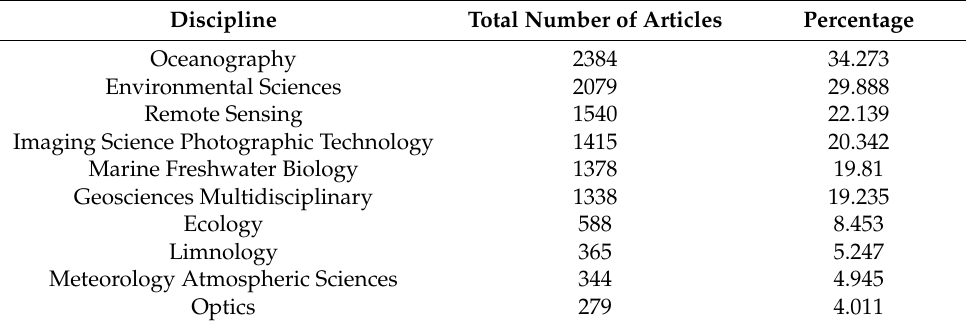
Table 1. Distribution of major disciplines during 1990–2020 (there is an overlap between the discipline percentages in the table).